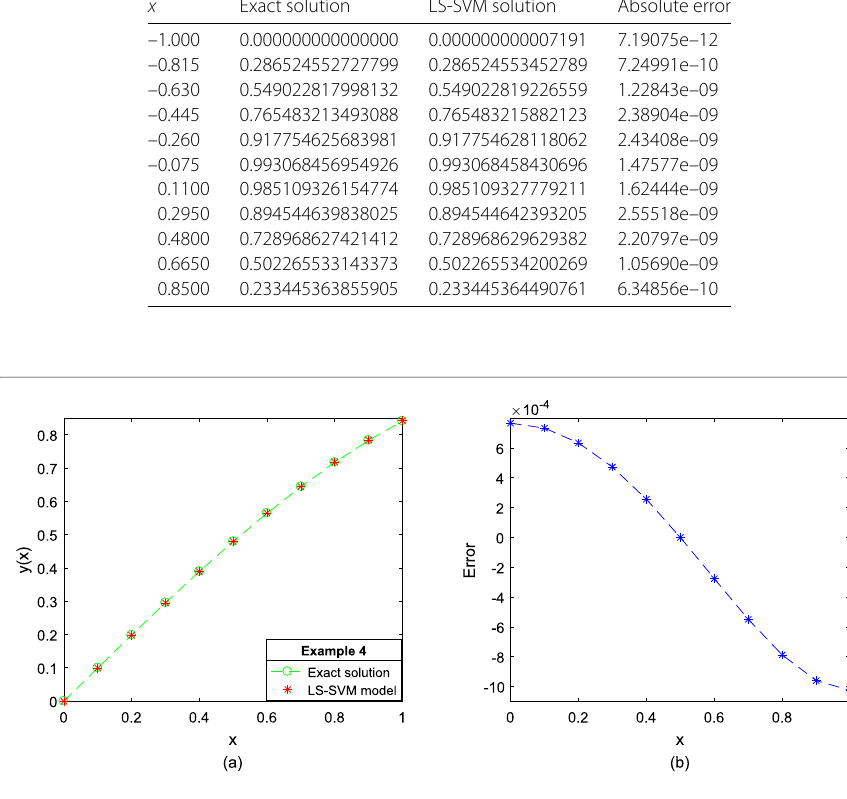
subject to multi-point boundary conditions y (cid:6) (0) = 1, y ( 1 alytic solution is y = sin ( x